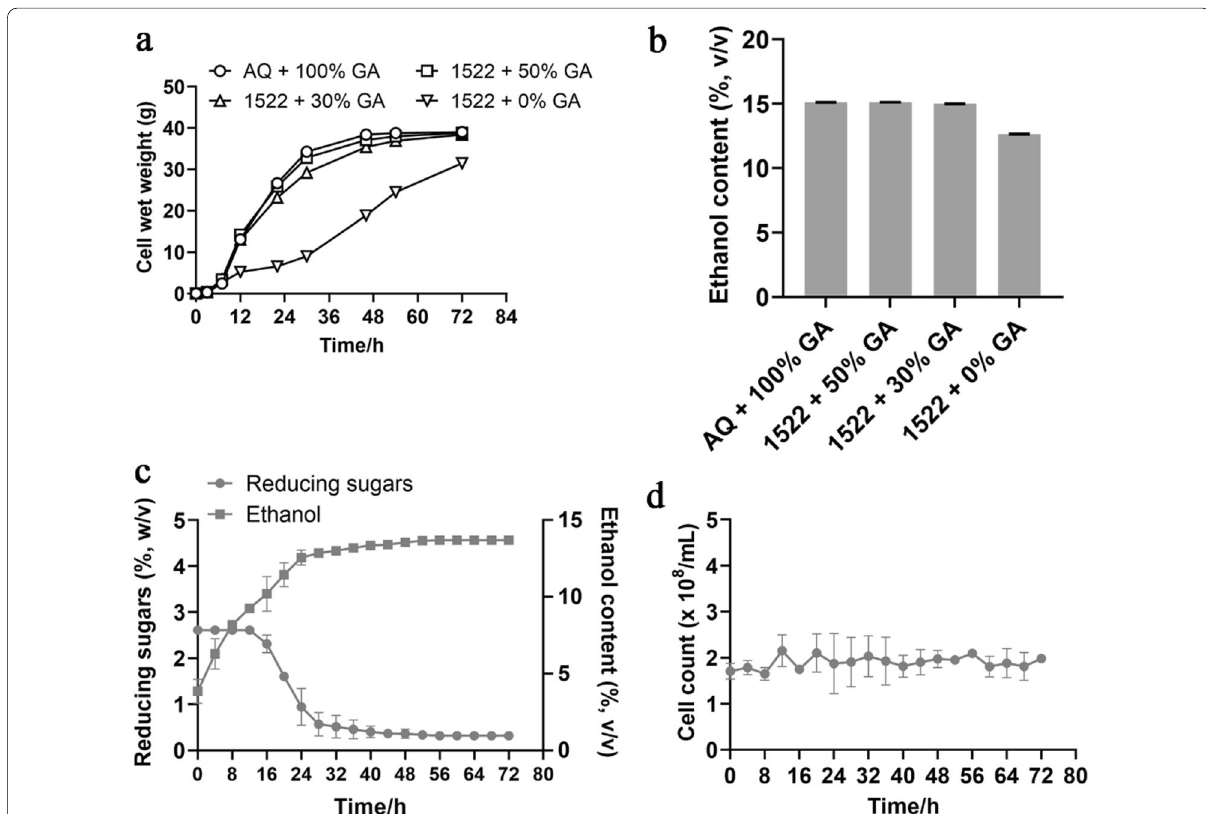
Fig. 2 Corn starch fermentation by CIBTS1522 at a small ( a , b ) and industrial scale ( c , d , respectively). The cell wet weight during the fermentation time ( a ) and the final ethanol content ( b ) at 72 h. 1522 was short for CIBTS1522, the control was AQ strain supplemented with 100% glucoamylase ( a , b ). At the industrial scale, the reducing sugars and ethanol content ( c ) and the cell count ( d ) were detected. Error bars represent the standard deviation from the mean of two replicates. GA glucoamylase